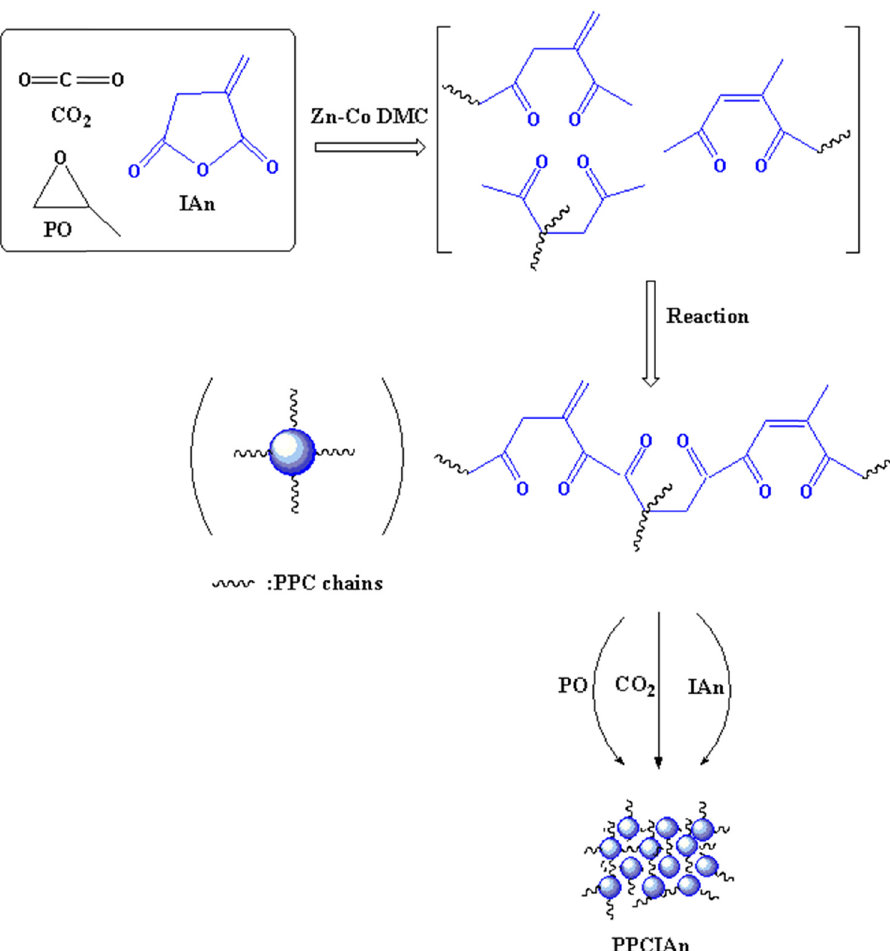
Figure 2: Formation of networks as part of the CO 2 /PO copolymerization process taking place in the presence of IAn. PPC: polypropylene carbonate;